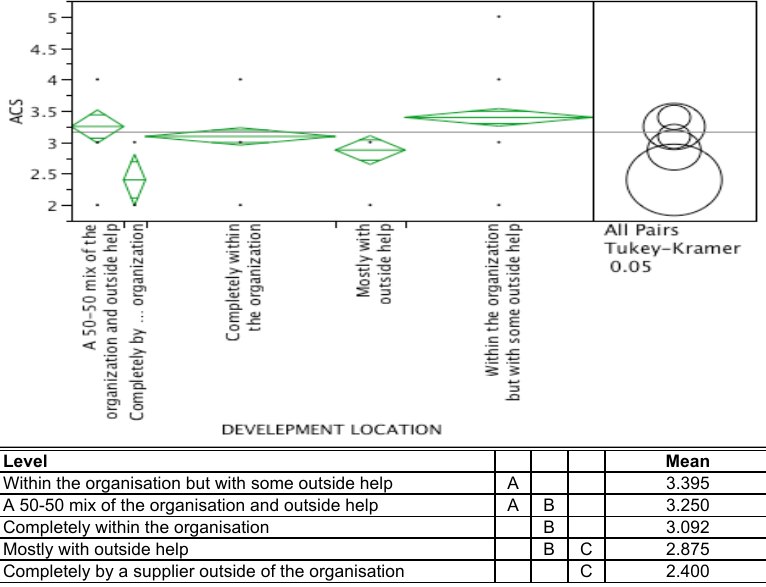
Effects of development location on satisfaction with the app cost effectiveness.